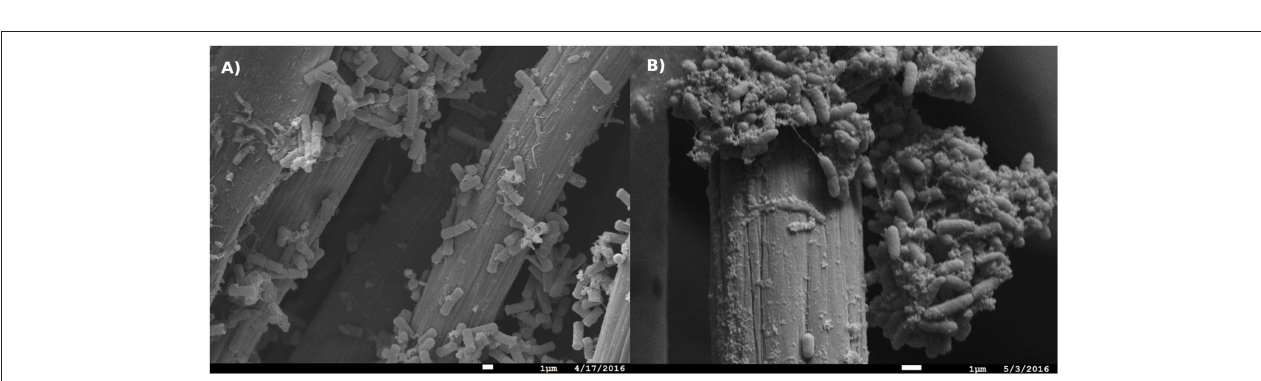
FIGURE 9 | Scanning electron micrograph of (A) Bacillus sp. (strain WE4-1A1-BC) and (B) Comamonas sp. (strain WE1-1D1) biomass associated with the working electrodes (Scale = 1 µ